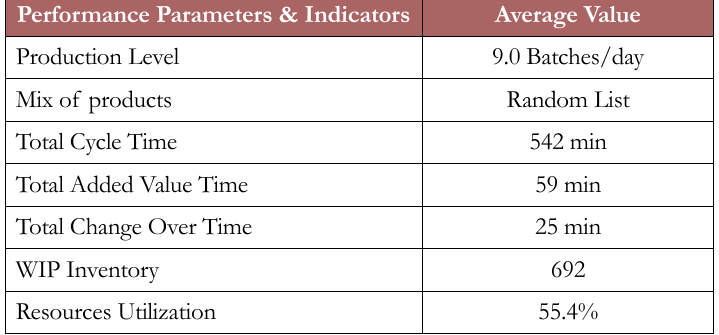
Table 5. Manufacturing Performances of SMED configuration